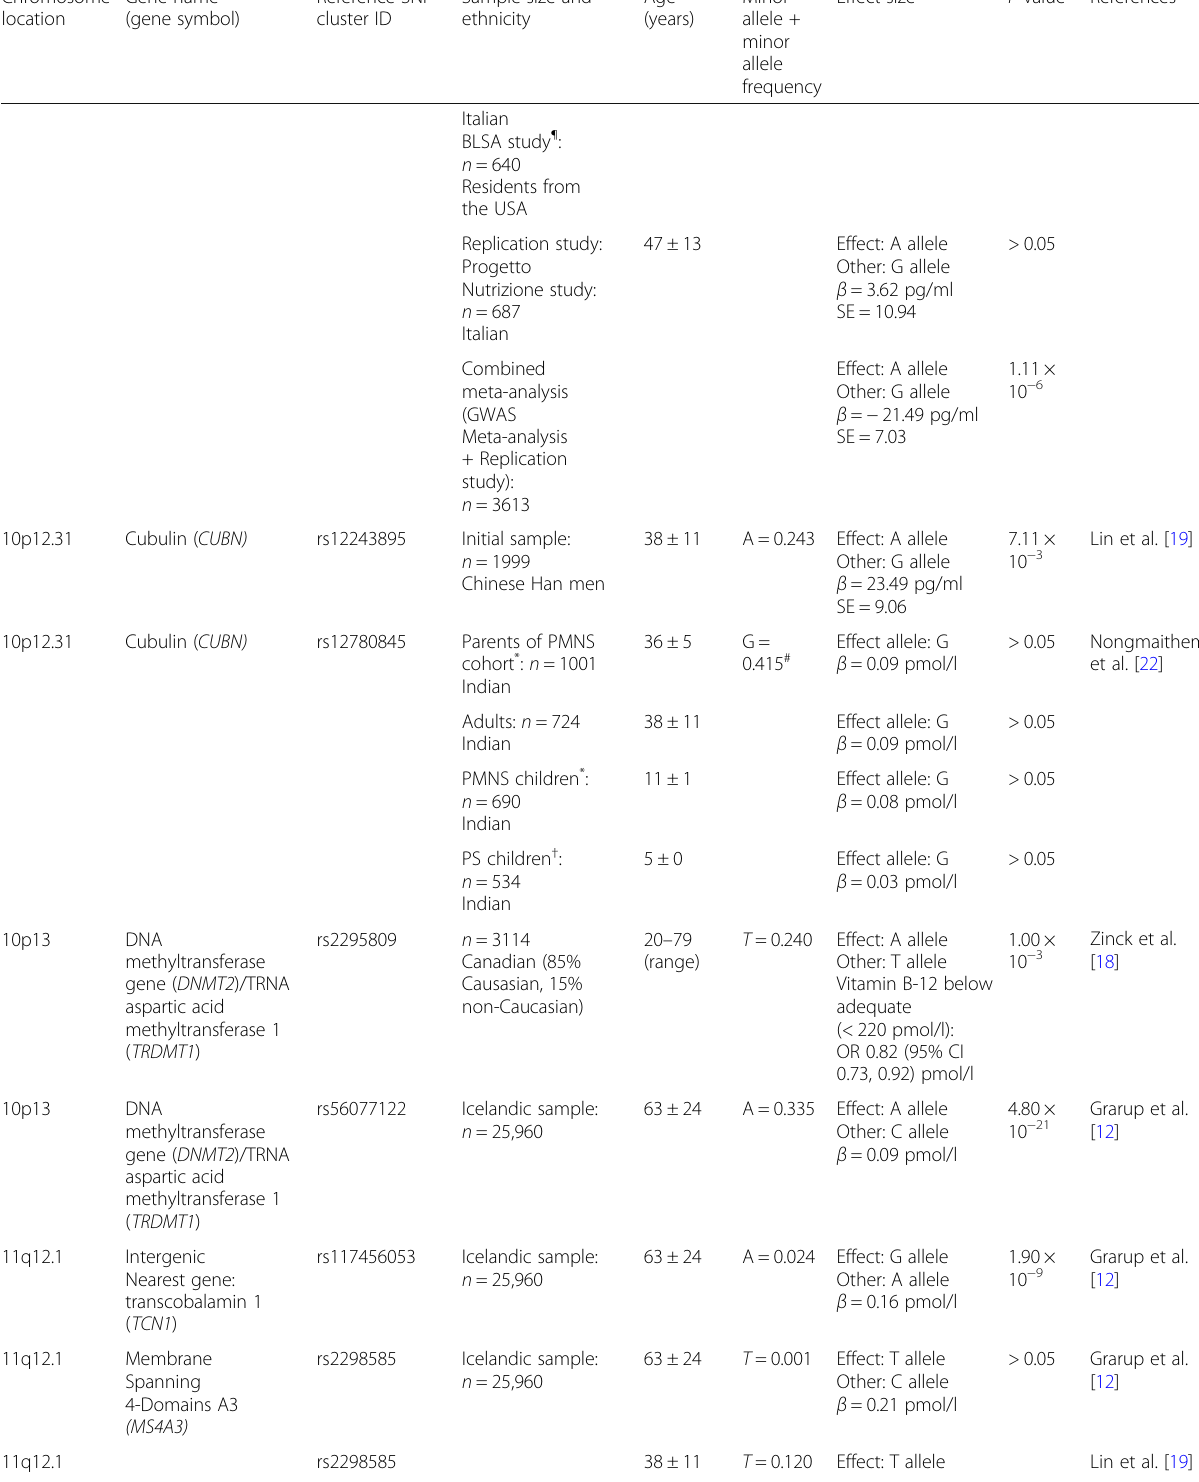
Table 1 Genome-wide association studies showing the association of SNPs with vitamin B12 concentrations. Genome-wide association studies testing the association between SNPs and vitamin B12 concentrations. The chromosome location, gene name, reference SNP cluster ID, sample size and ethnicity, mean age, observed frequency of the minor allele in the population, effect size and P value are shown in the table. The order of SNPs reflects the order of the chromosome location